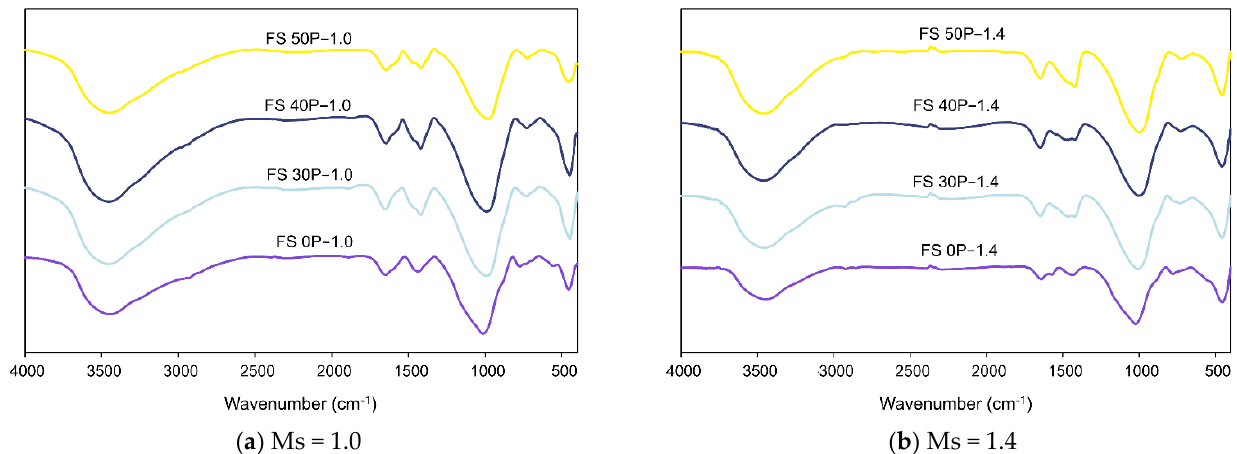
Figure 9. FTIR spectra of AAB paste under ambient